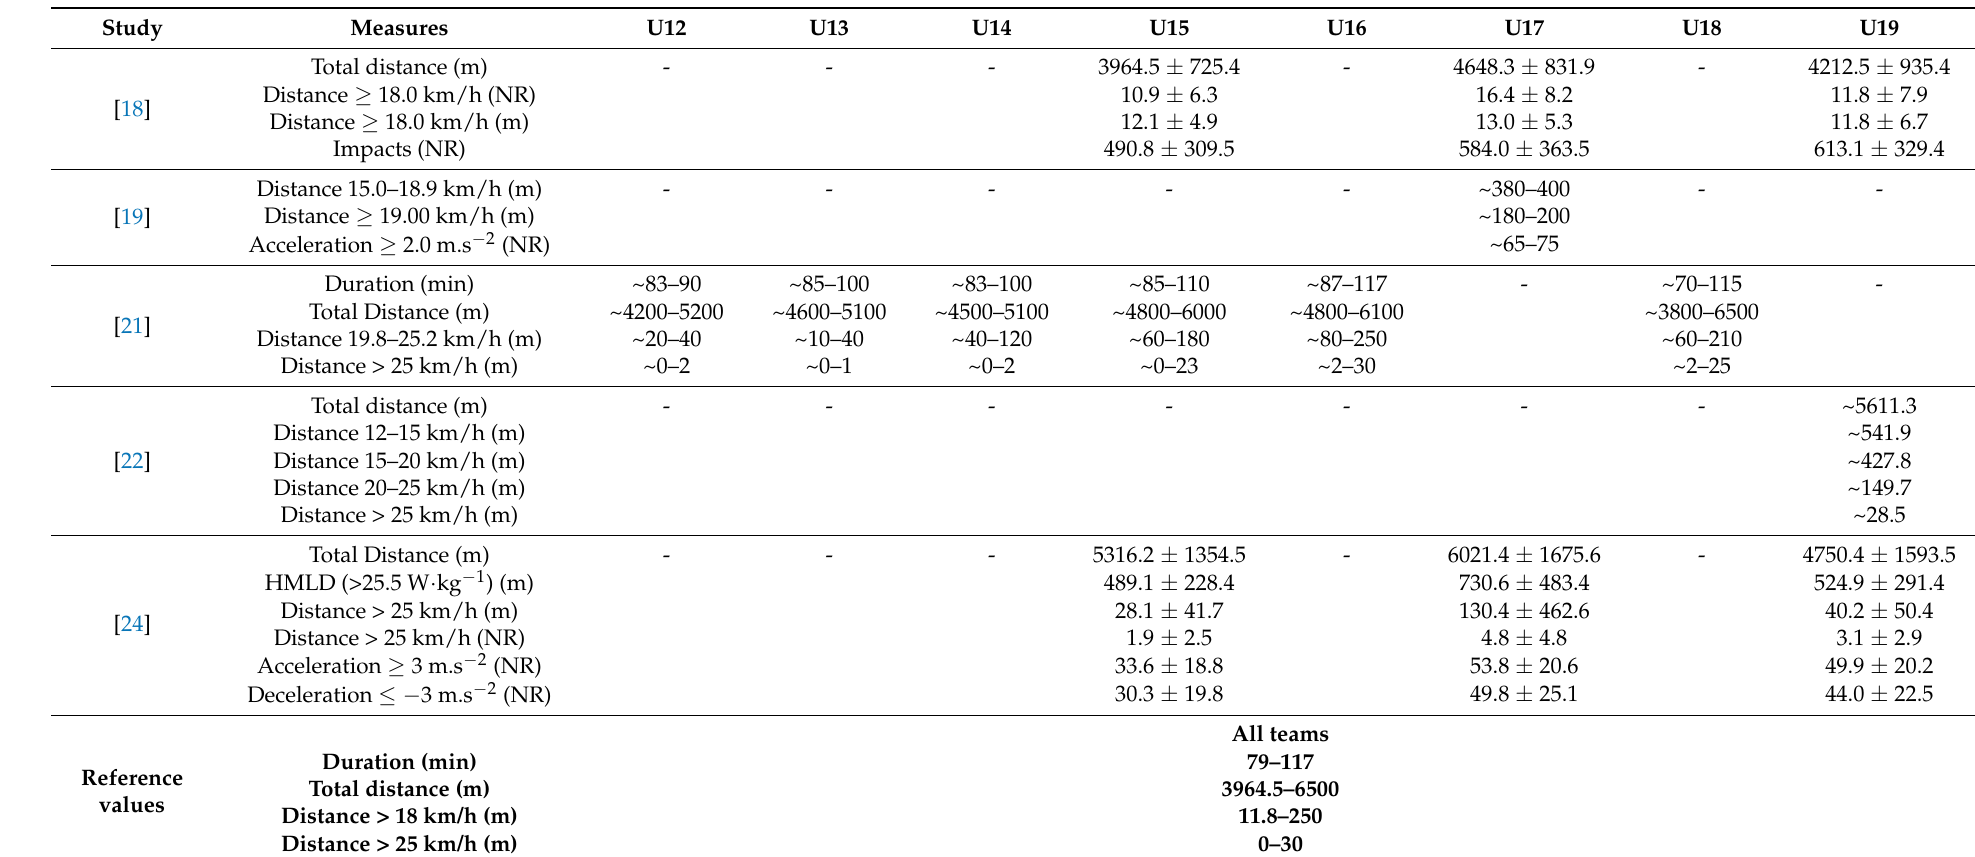
Table 4. Results for external training by overall